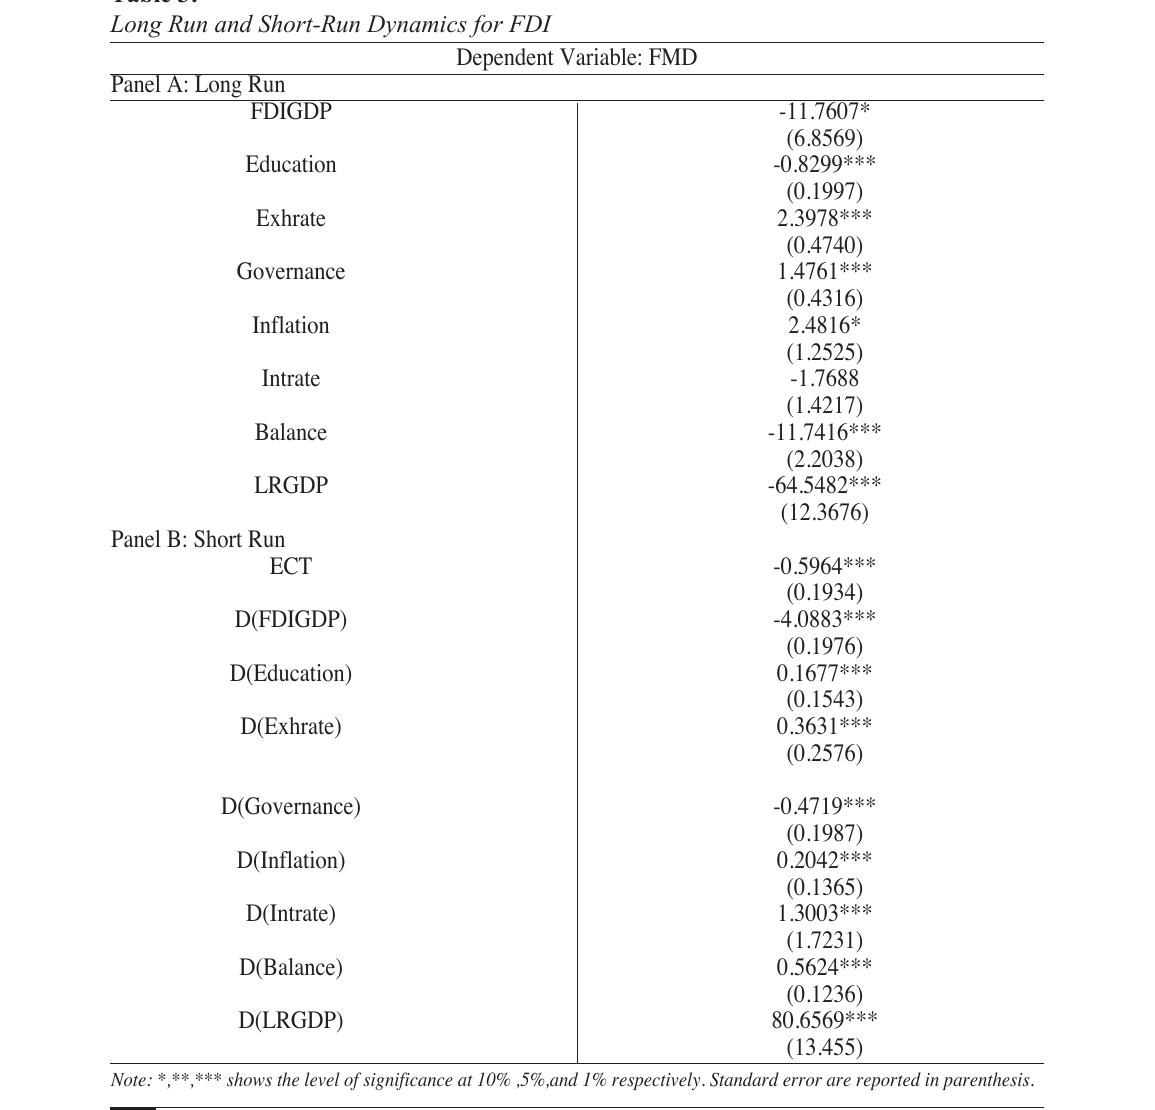
Table 3: Long Run and Short-Run Dynamics for FDI